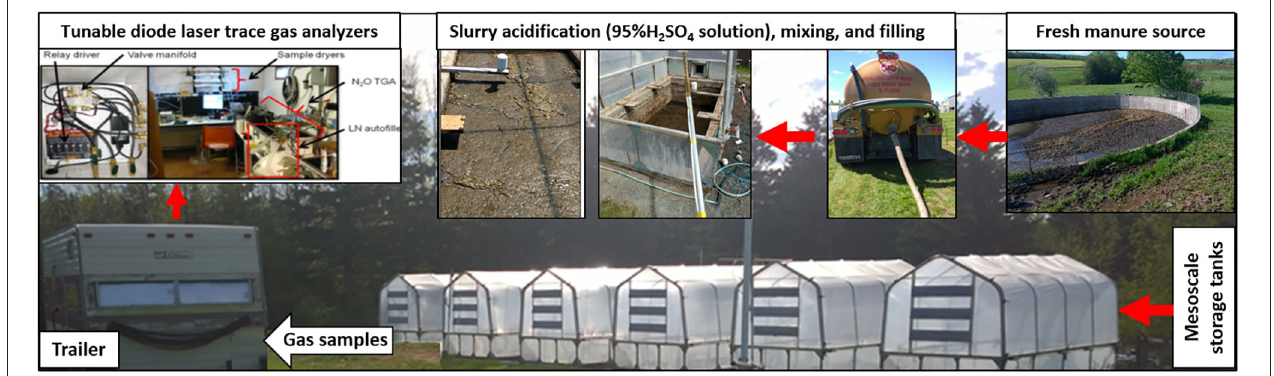
FIGURE 1 | The mesoscale study site indicating manure source, storage tanks, and slurry acidification.